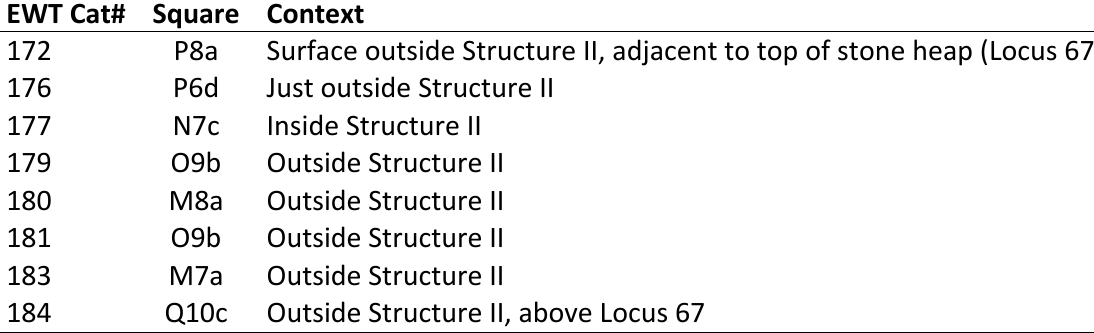
Table 1: The EN Unit 2 grooved basalts for this study and their provenience